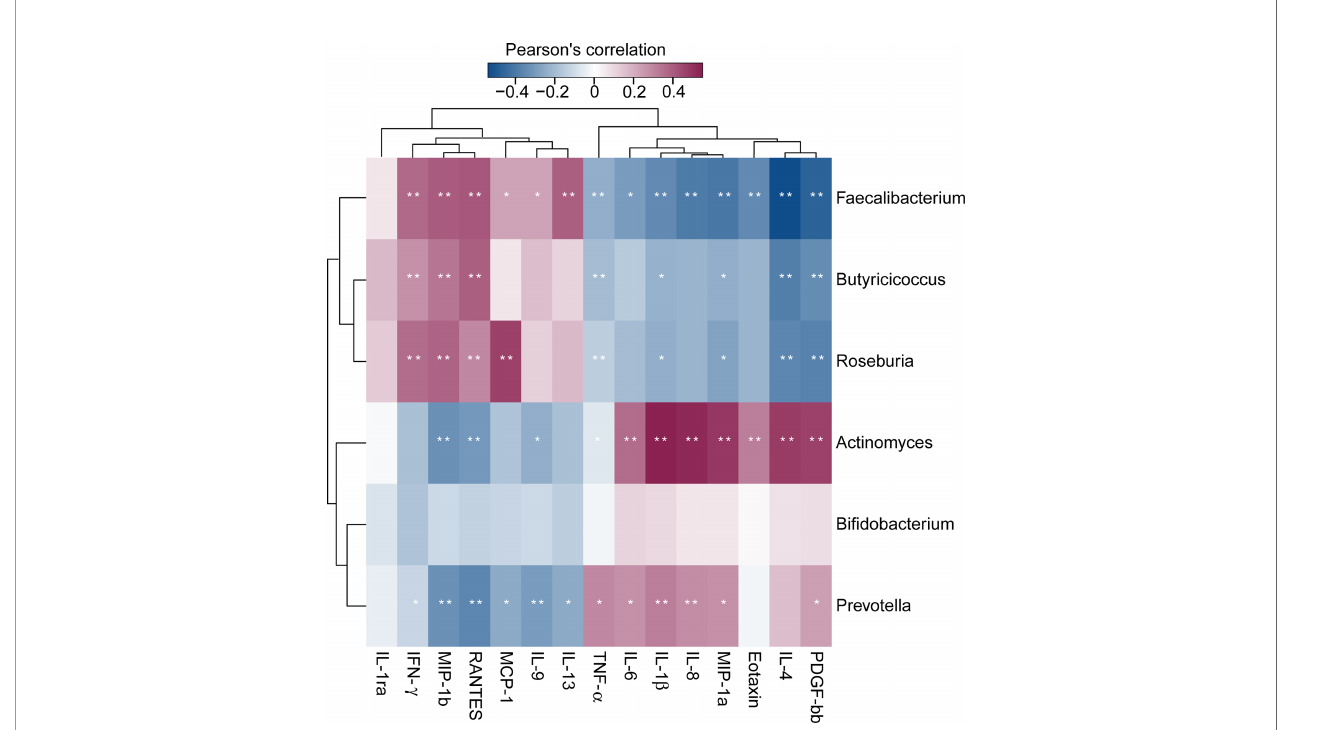
FIGURE 7 | Correlation between fecal microbiota, and pro- and anti-in fl ammatory cytokines and chemokines and clinical indicators. The heatmap shows partial Spearman ’ s correlation coef fi cients between 6 genera and host immunity in SZ patients. Spearman ’ s rank correlation (r) and probability (p) were used to evaluate statistical importance. *p < 0.05; **p <